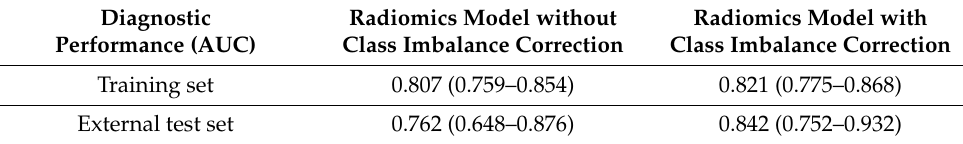
Table 3. Diagnostic performance of radiomics model.